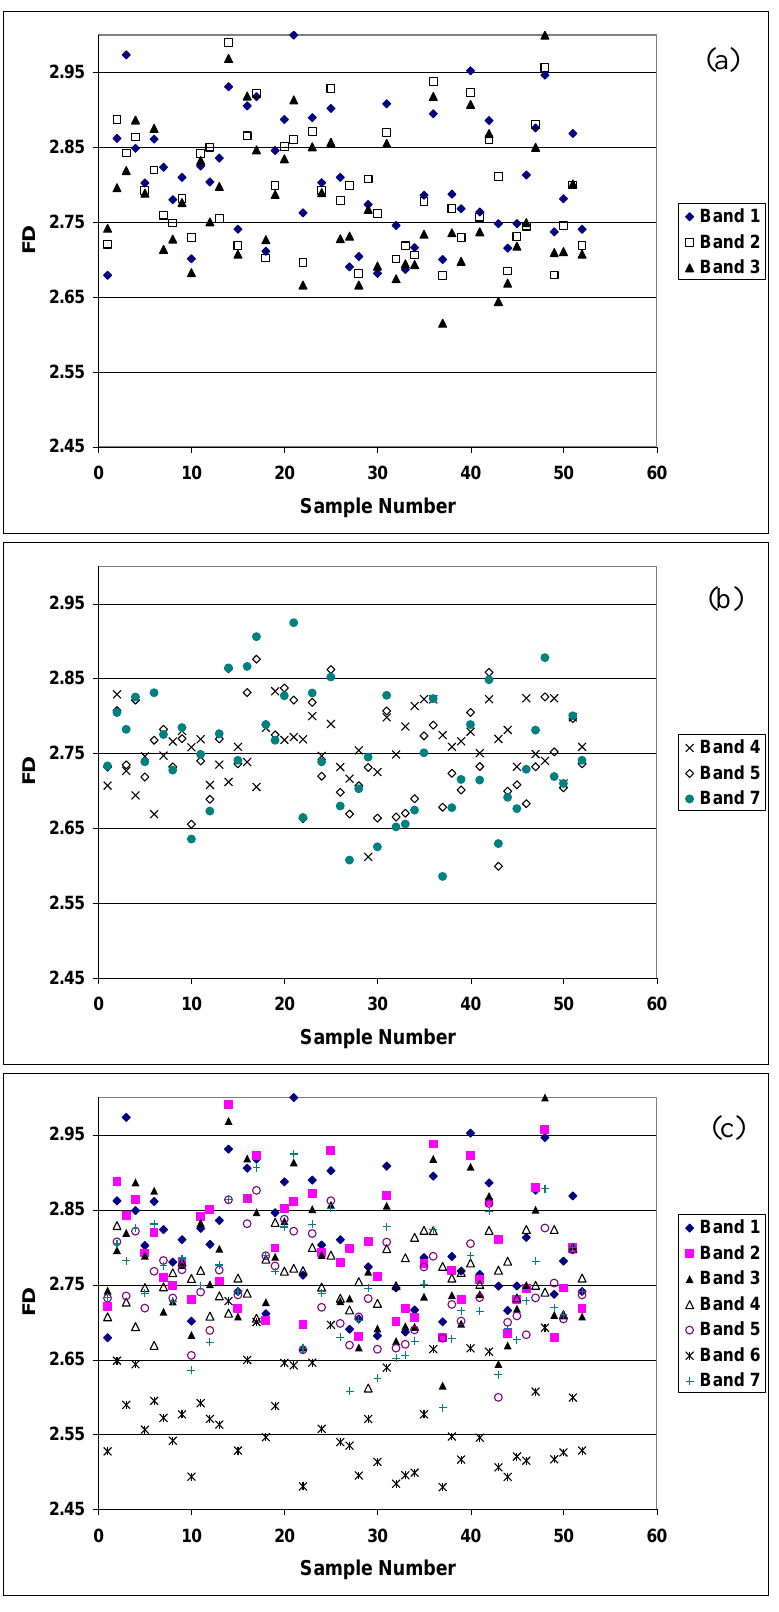
Figure 13. Fractal dimension values of samples within Oakmulgee National Forest: (a) visible bands (b) near and middle infra red bands (c) all